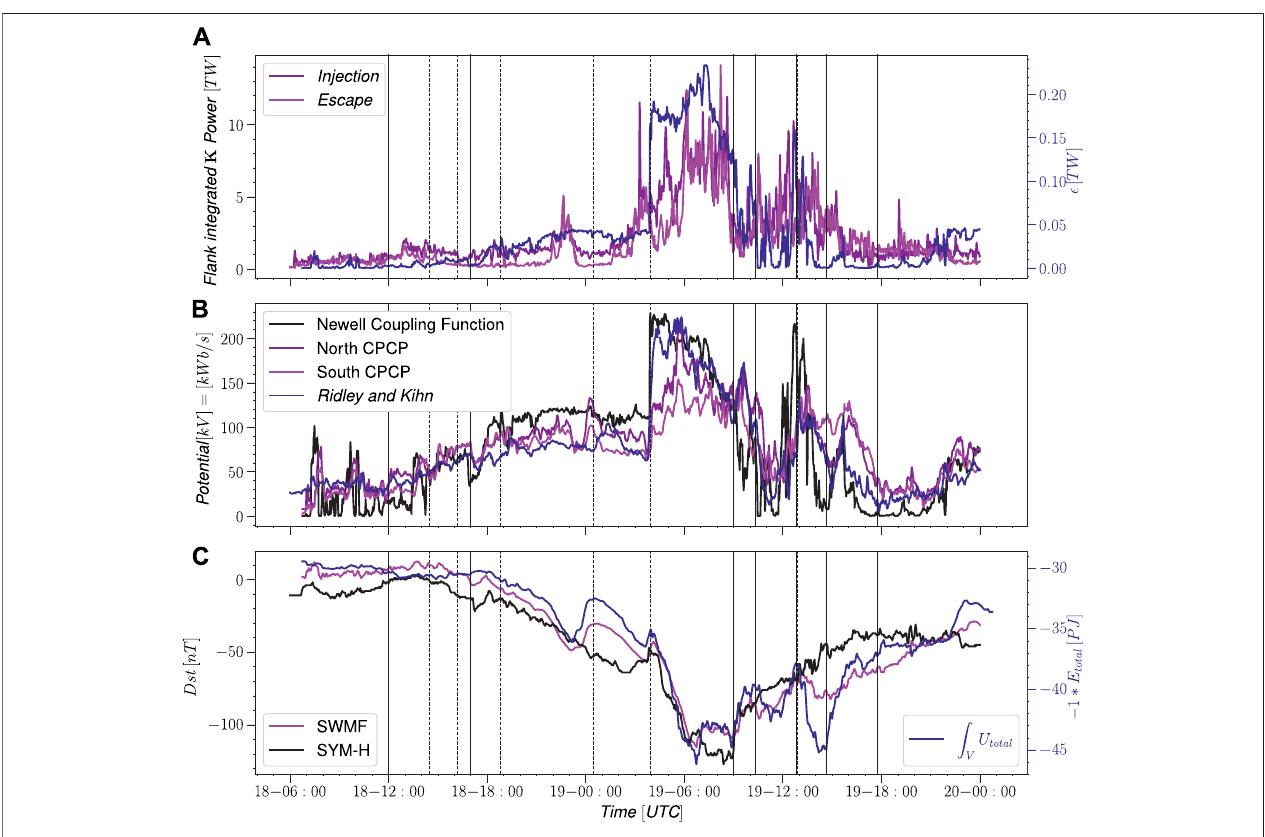
FIGURE12|(A) :Total energy transfercomparedwithAkasofucoupling parameter. (B) : Crosspolar cappotential from simulation and empirical model, compared withsolarwindcouplingofNewell. (C) :Groundmagneticperturbation fromsimulation(magenta)andobservation(black),plottedwithenergydensityintegratedoverthe de fi ned magnetosphere